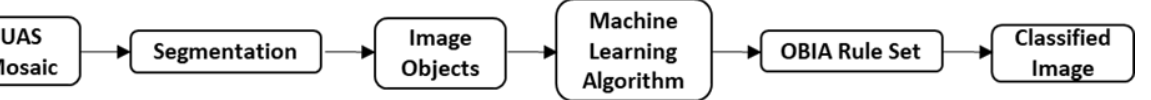
Figure 4. Classification workflow used in this study. The UAS mosaic was segmented to produce image objects, the image objects were classified using an ML algorithm, and then the classified objects were further refined using a post-ML OBIA rule set in eCognition.